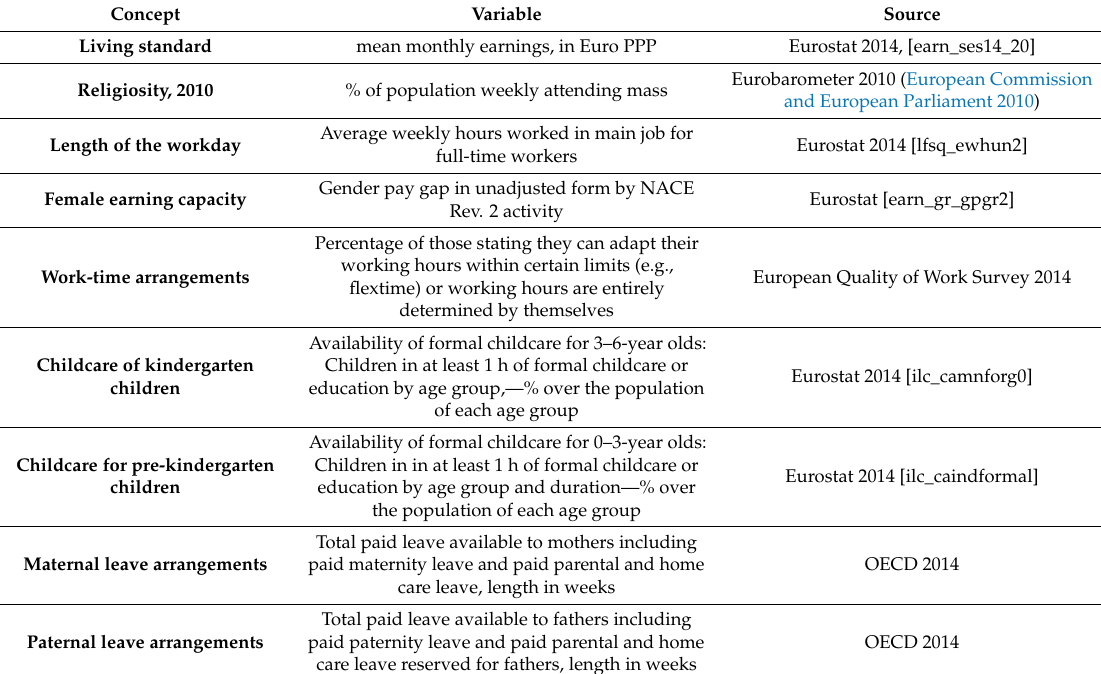
Table A1. Macro variables for 2014: definitions and sources of the macro-level variables.